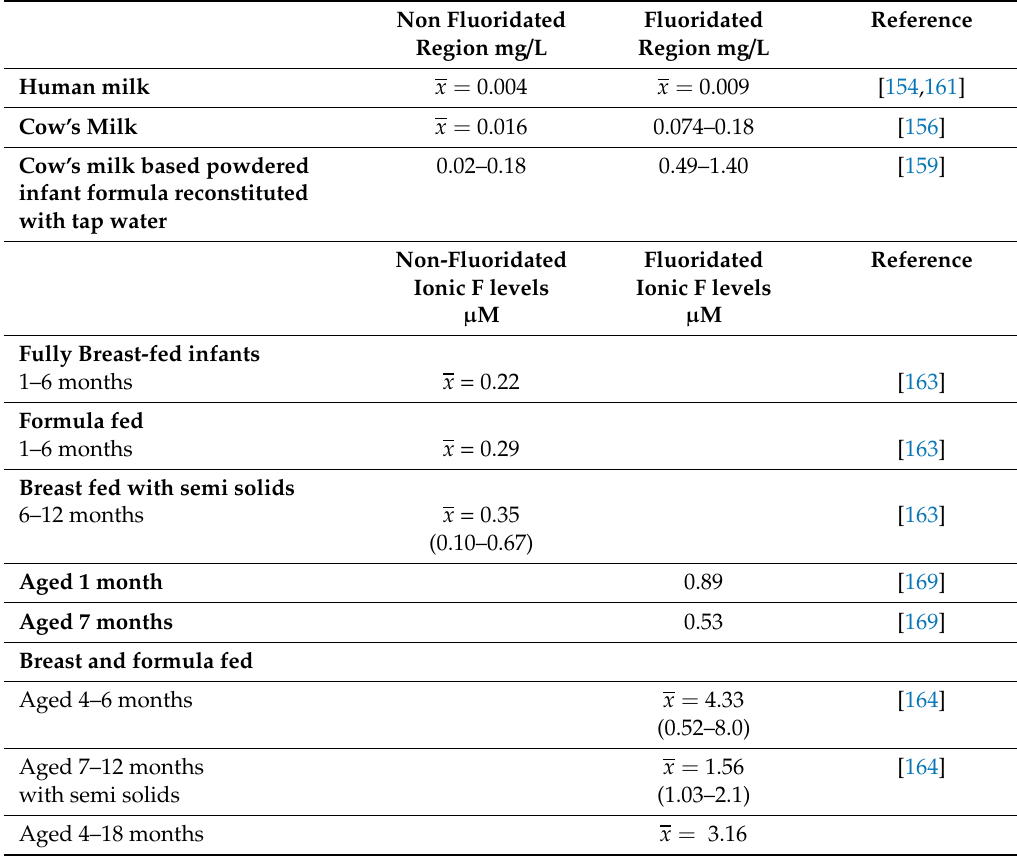
Table 1. Fluoride levels in human milk, cow’s milk and infant formula and serum / plasma fluoride levels in infants less than 12 months of age in fluoridated and non-fluoridated